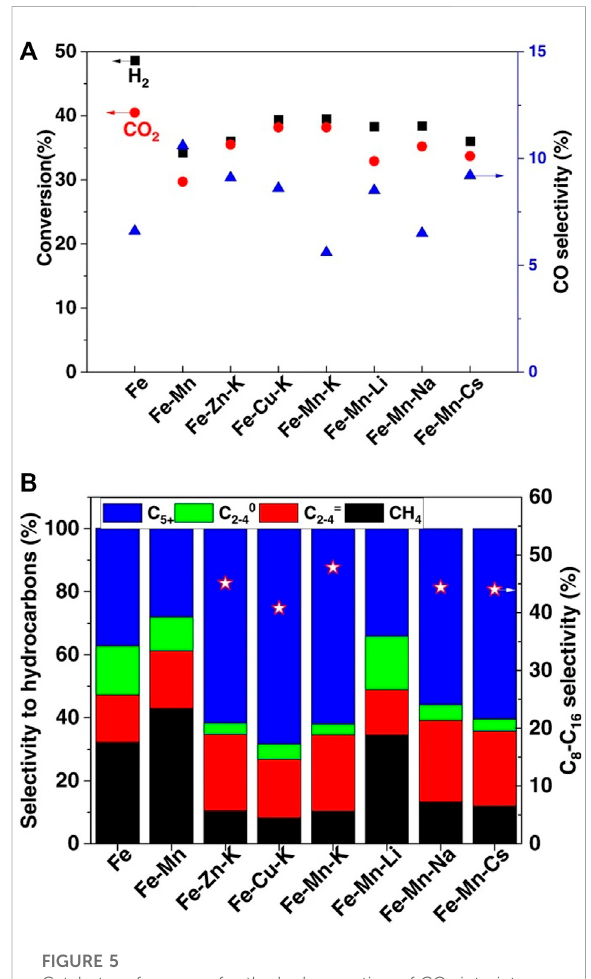
FIGURE 5 Catalyst performance for the hydrogenation of CO 2 into jet fuel range hydrocarbons over various Fe-based catalysts (Yao et al., 2020) Copyright © 2020, The Authors. (A) CO 2 conversion and CO selectivity under a reaction time of 20 h. (B) Selectivity for different hydrocarbon products under a reaction time of 20